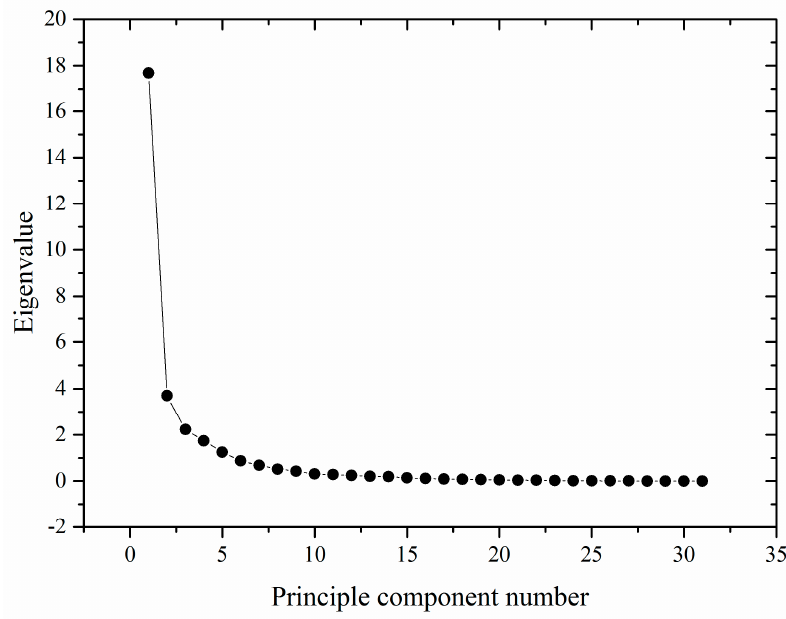
Figure 2. Contributions of the total variance accounted for by the PCs. The maximum variance method is to find the rotational load that can maximize the variance of the square of the load in each column of the load matrix. After the data were rotated by the varimax method, the factor loadings were closer to 0 or 1, which could better explain and summarize the factors under each PC. The greater the factor loadings, the higher the contribution ratio under the PC. The results of PCA after rotation are shown in Table 3. K, Mg, soluble sugar content, and Na had a positive correlation with the first PC; however, the moisture content was negative. Because there were highly negative correlations between soluble sugar content and moisture content, moisture content had a lower loading value, excluding it from the main quality parameters. For PC2, phenylalanine, arginine, lysine, leucine, tyrosine, and histidine were the main influencing parameters. Therefore, no main quality parameter was selected from PC2. The main influencing parameters of PC3 were fresh mass, cAMP, and edible rate. Shape ratio and Zn were the main influencing parameters in the fourth and fifth PCs, respectively. However, the varimax rotated factor loadings of PC2 and PC4 were not high (<0.8); therefore, no main parameter was screened from them. As a result, soluble sugar content (X1), fresh mass (X3), edible rate (X5), Na (X7), Mg (X8), K (X9), Zn (X13), and cAMP (X15) were selected as the main parameters. Table 3. Varimax rotated factor loadings of the first five principal components (PCs).